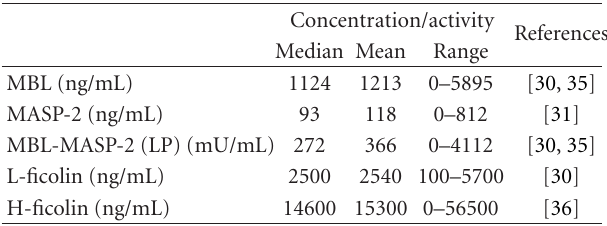
Table 1: Average (median, mean) concentrations or activities of selected complement lectin pathway factors (based on own